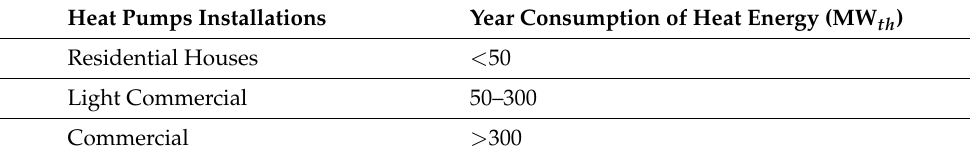
Table 1. Classification of GSHP systems according to the size of their